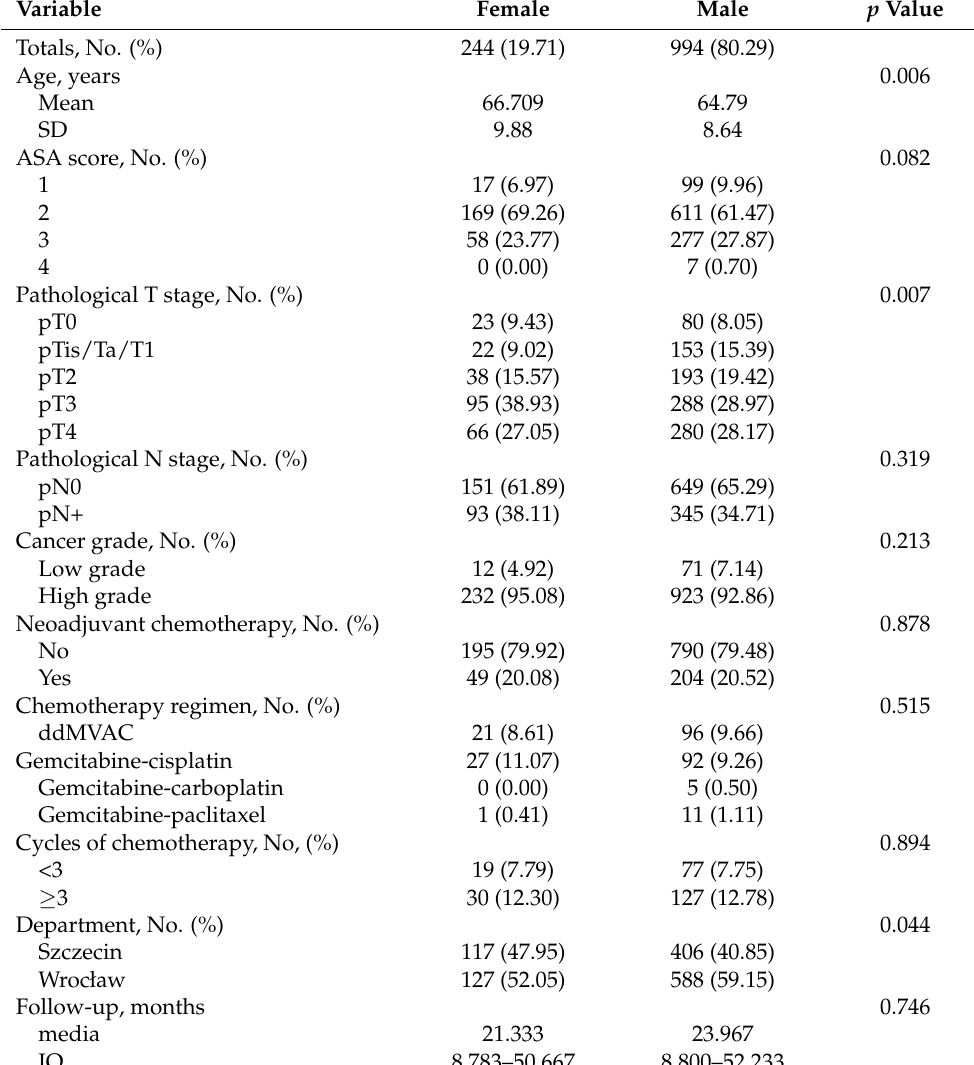
Table 1. Baseline patients’ characteristics according to